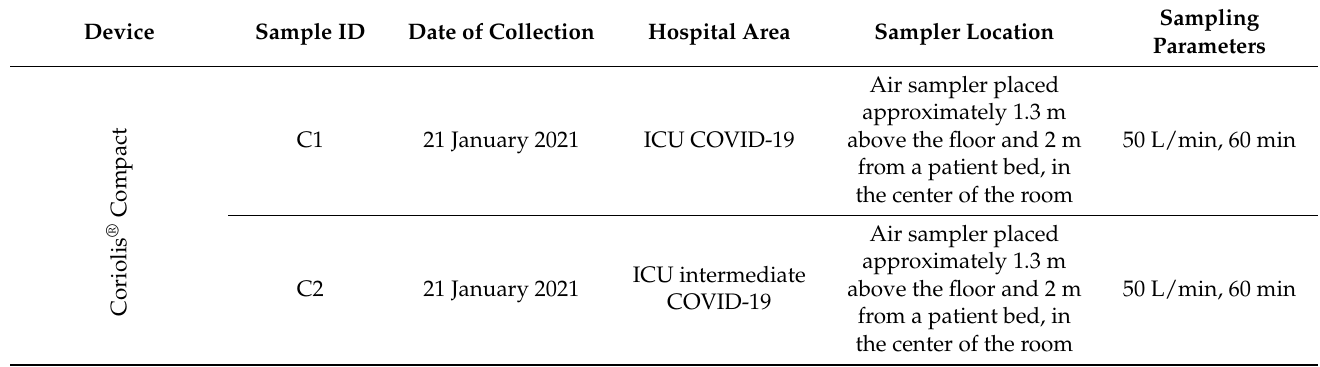
Table 2. Details of the air samples’ collections for SARS-CoV-2 RNA detection in the Hospital.